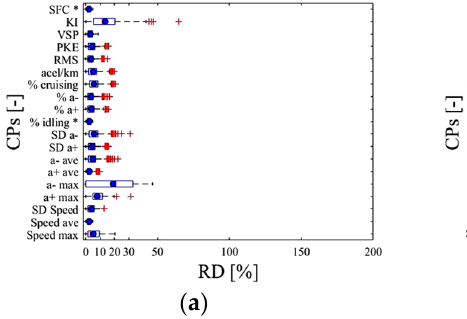
Figure 7. Dispersion of the relative differences (RD) of the CPs* obtained from the 1000 DCs con- structed from the CPs of the driving pattern for ( a ) low SFC, ( b ) typical SFC, and ( c ) high SFC sce- narios. * The building criterion considers the Specific Fuel Consumption (SFC), percentage in idling (% idling) and average speed (speed ave) parameters.